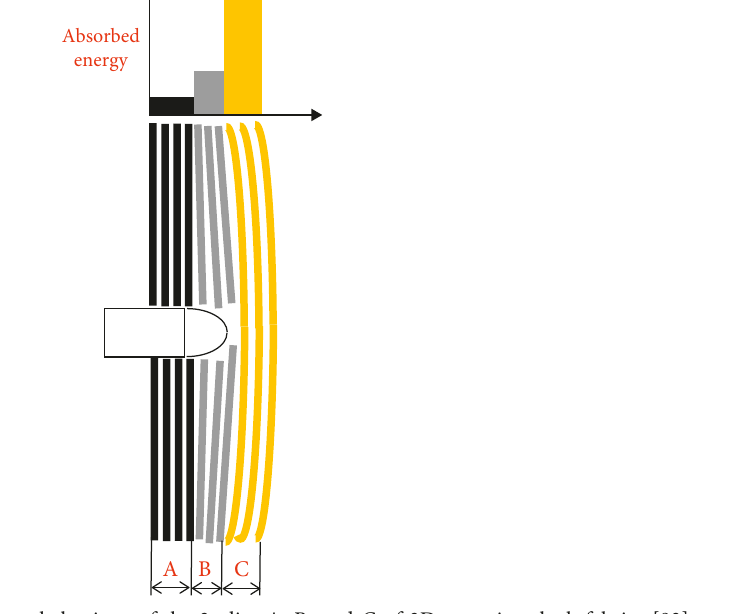
Figure 10: Decomposition of impact behaviour of the 3 plies A, B, and C of 3D warp interlock fabrics